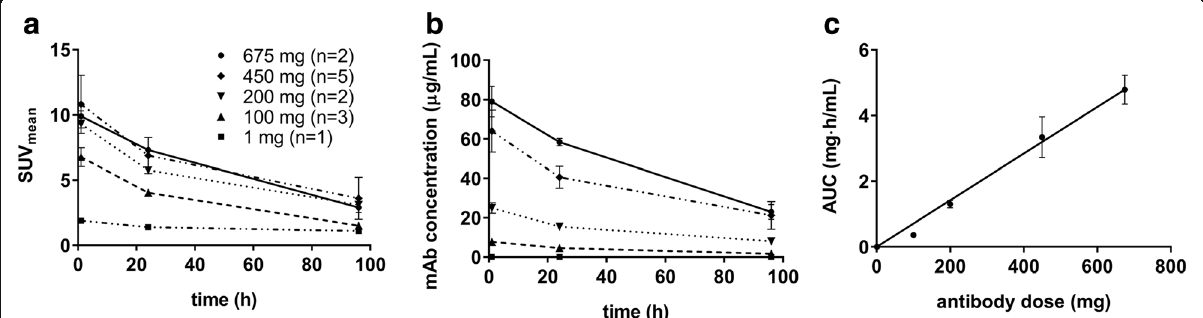
Fig. 3 Blood pool concentrations of 89 Zr-RG7356 and RG7356. a Radioactivity concentrations of 89 Zr-RG7356 in blood pool as function of time.